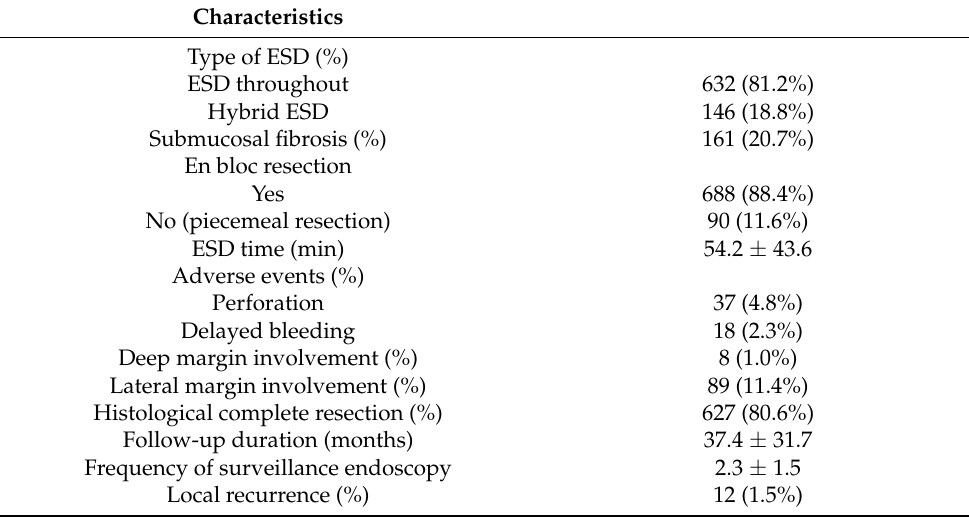
Table 2. Colorectal ESD procedure-related outcomes.